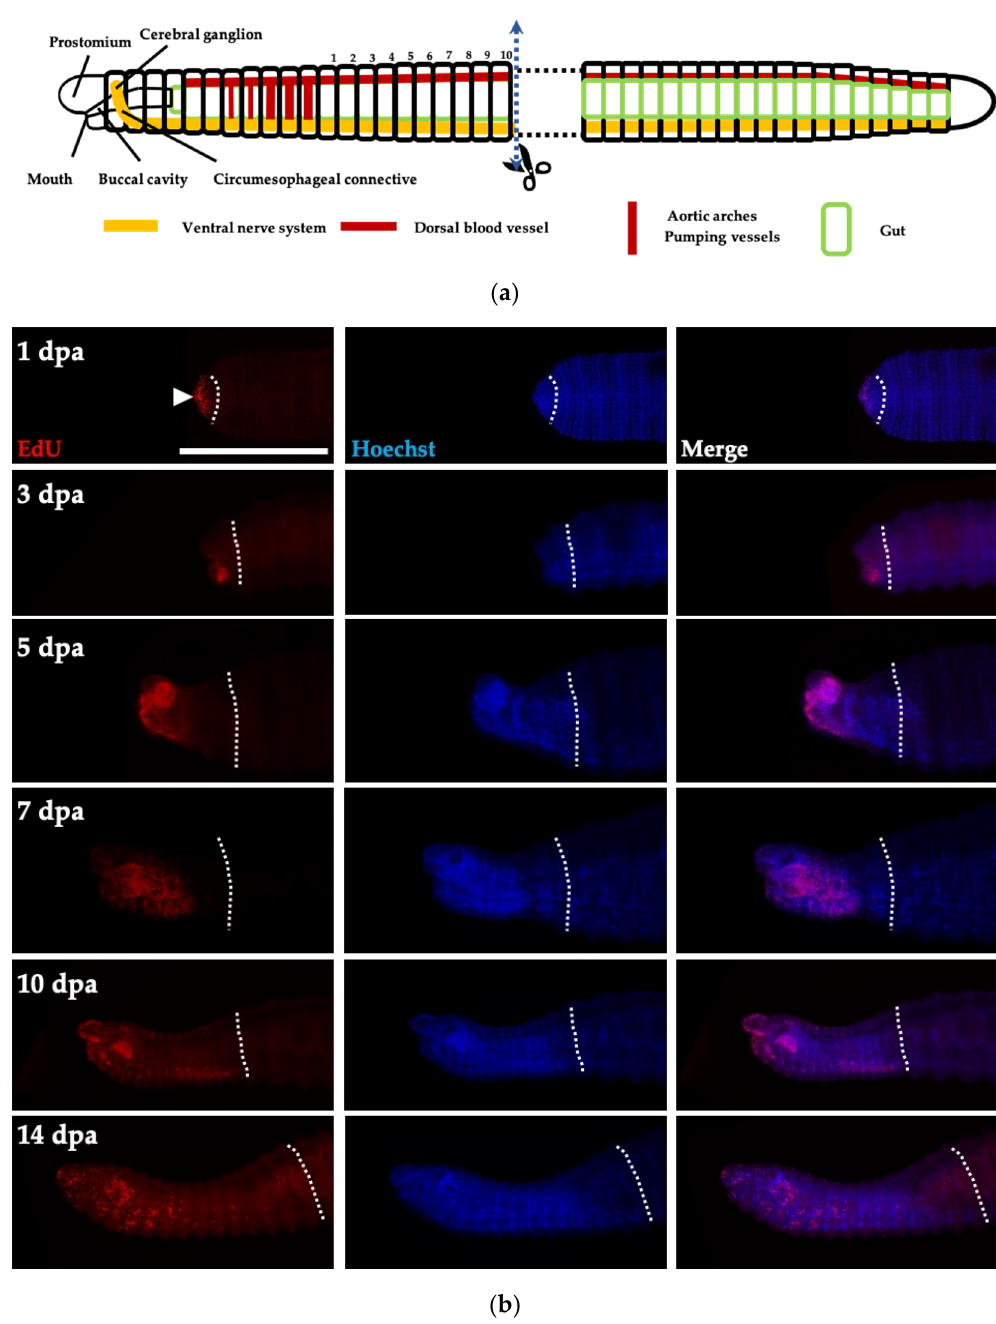
Figure 5. Active cell proliferation in regeneration. ( a ) The schematic cartoon indicating the amputation site, which is located in the trunk region, lacking cell proliferation. ( b ) Cell proliferation in regenerating tissues is visualized by EdU staining (red) at indicated days post-amputation (dpa). Nuclei are marked by Hoechst staining (blue). Dotted lines indicate the site of amputation. Scale bar, 500 μm.